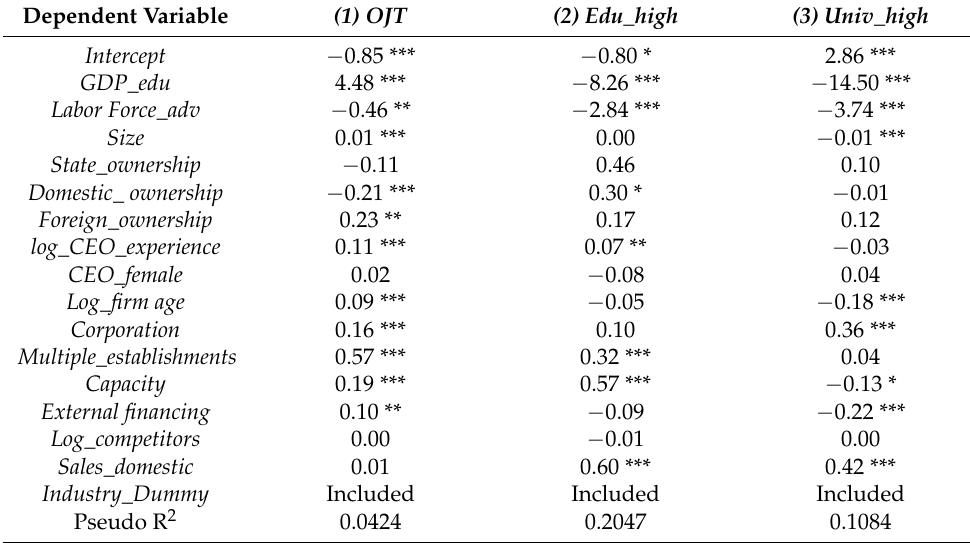
Table 5. First stage regression results (total observations =